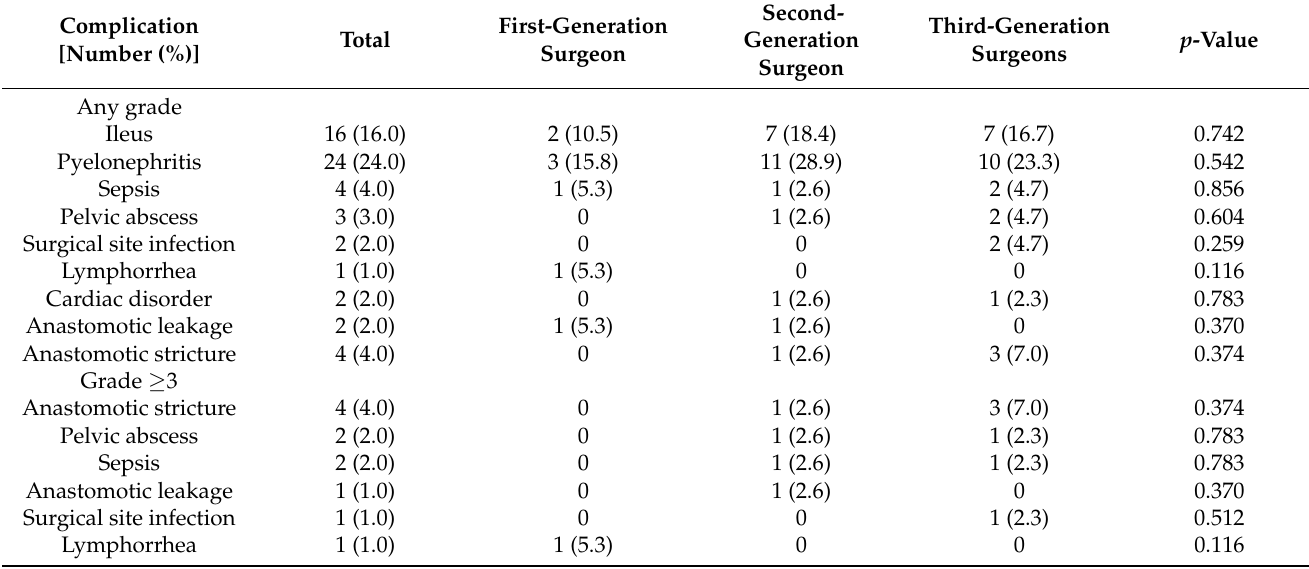
Table 4. Postoperative complications according to the Clavien–Dindo classification.